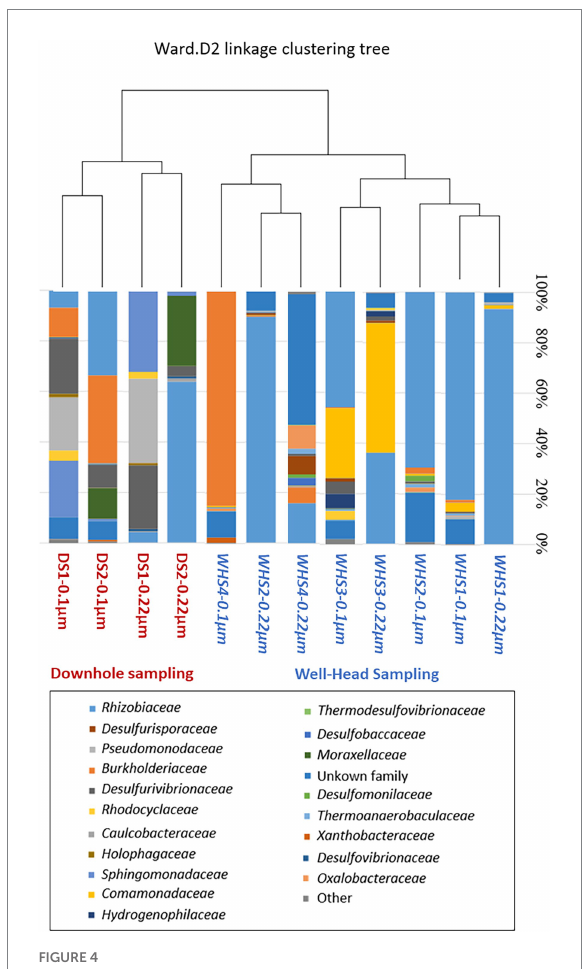
FIGURE 4 Jaccard’s analysis of the beta diversity and comparison representation of the dominant bacterial families based on the 16S rRNA gene (v3-v4) in different formation water samples from the downhole sampler (DS, red) and the wellhead sampler (WHS, blue). The deep aquifer bacterial community was obtained